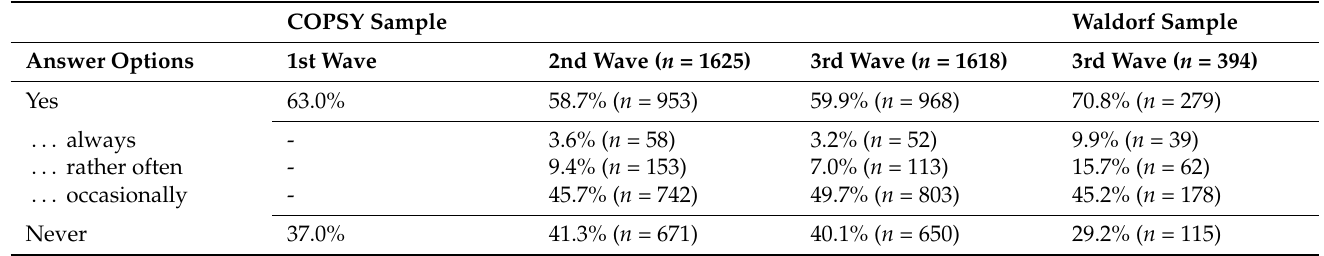
Table 2. Would you like support in the interaction with your child during the COVID-19 pandemic? COPSY Sample Waldorf Sample